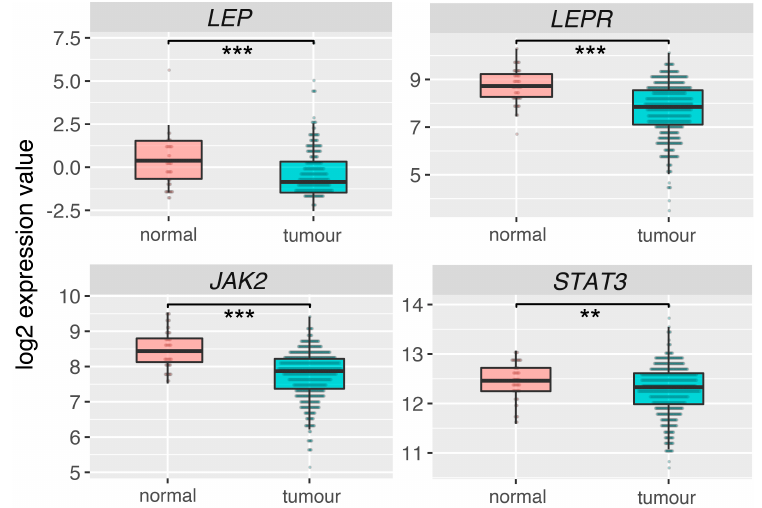
Figure 11. Expression of leptin ( LEP ), leptin receptor ( LEPR ) and its main downstream signaling genes ( JAK2 , STAT3 ) in normal prostate and adenocarcinoma. Analysis based on data from The Cancer Genome Atlas (TCGA). Results are presented as medians with IQRs. Statistical comparison by Mann-Whitney test: ** p < 0.02; *** p < 0.01.